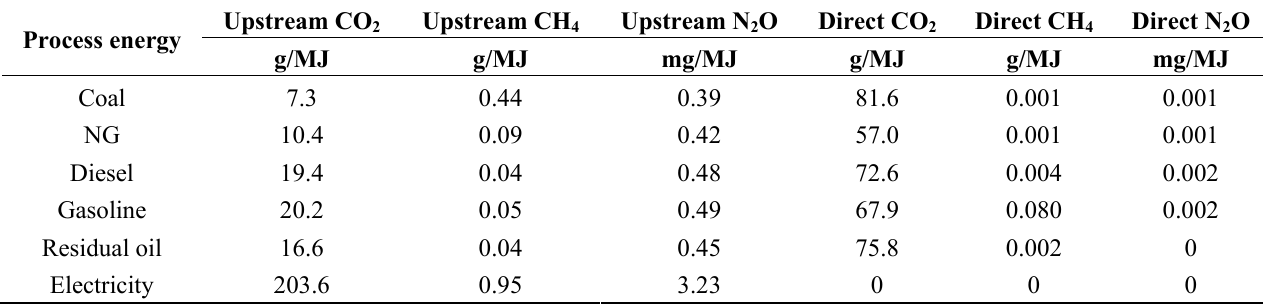
Table 2. Life cycle upstream and direct emission factors for secondary energy in China. Process energy